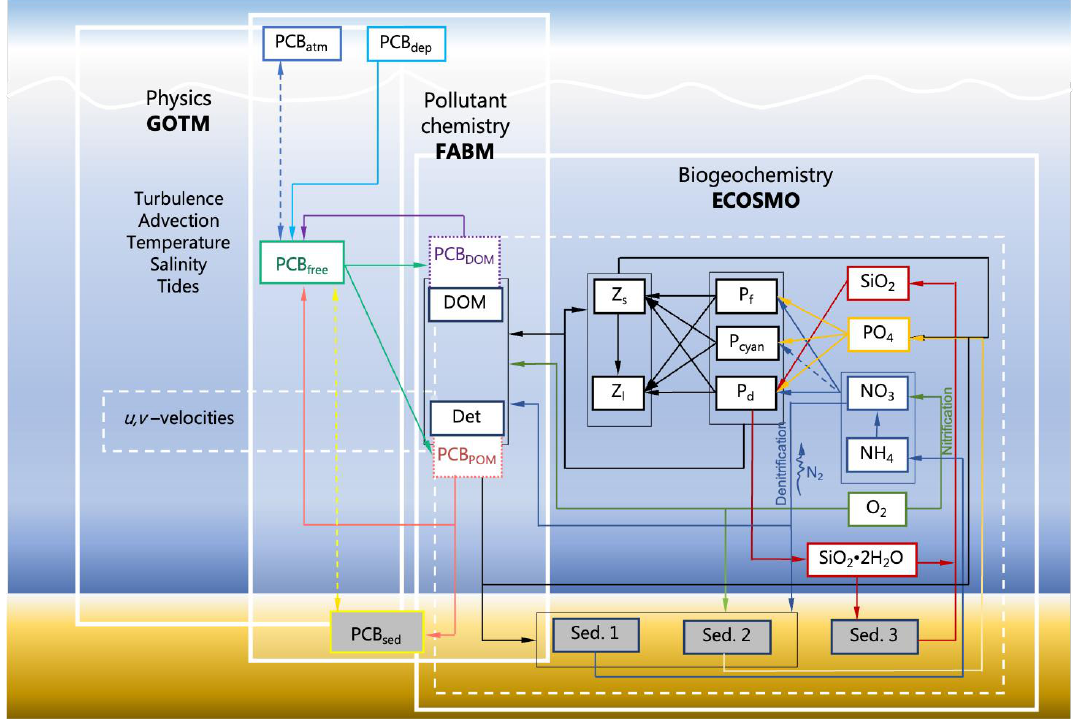
Figure 2. Overview of the coupled model GOTM-ECOSMO-FABM ( Det stands for Detritus) with an emphasis on the flow between the different model compartments of ECOSMO (incl. 2 groups of zooplankton: Z s , Z l ; 3 groups of phytoplankton: P f , P cyan , P d ) (detailed description of ECOSMO in Section 2.3 or Daewel and Schrum, 2013 [22]).